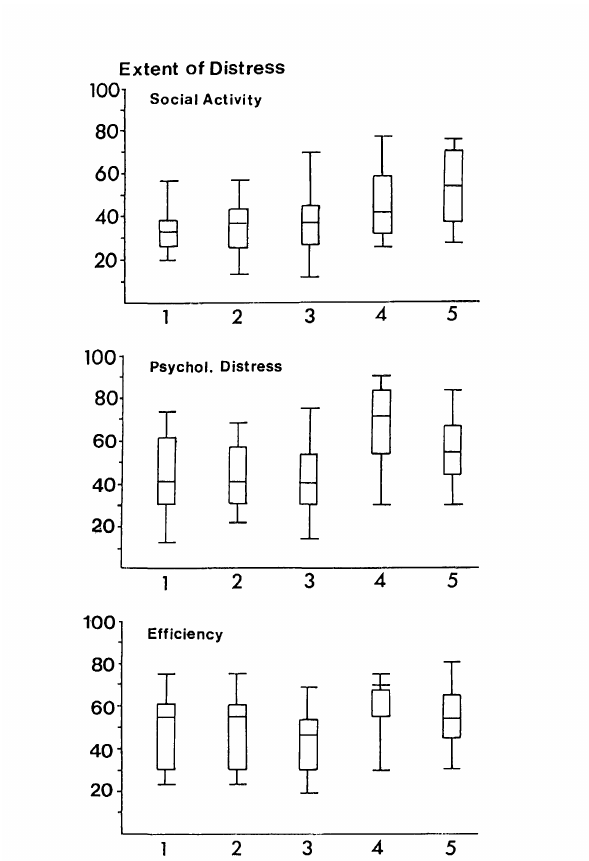
FIG. 3. Extent of distress in various aspects (according to the Inventory of Distress in Parkinson's disease). Boxplots of the scores for each group: 1, single female patients; 2, females, stable partnership; 3, males, stable partnership; 4, females, impaired partnership; 5, males, impaired